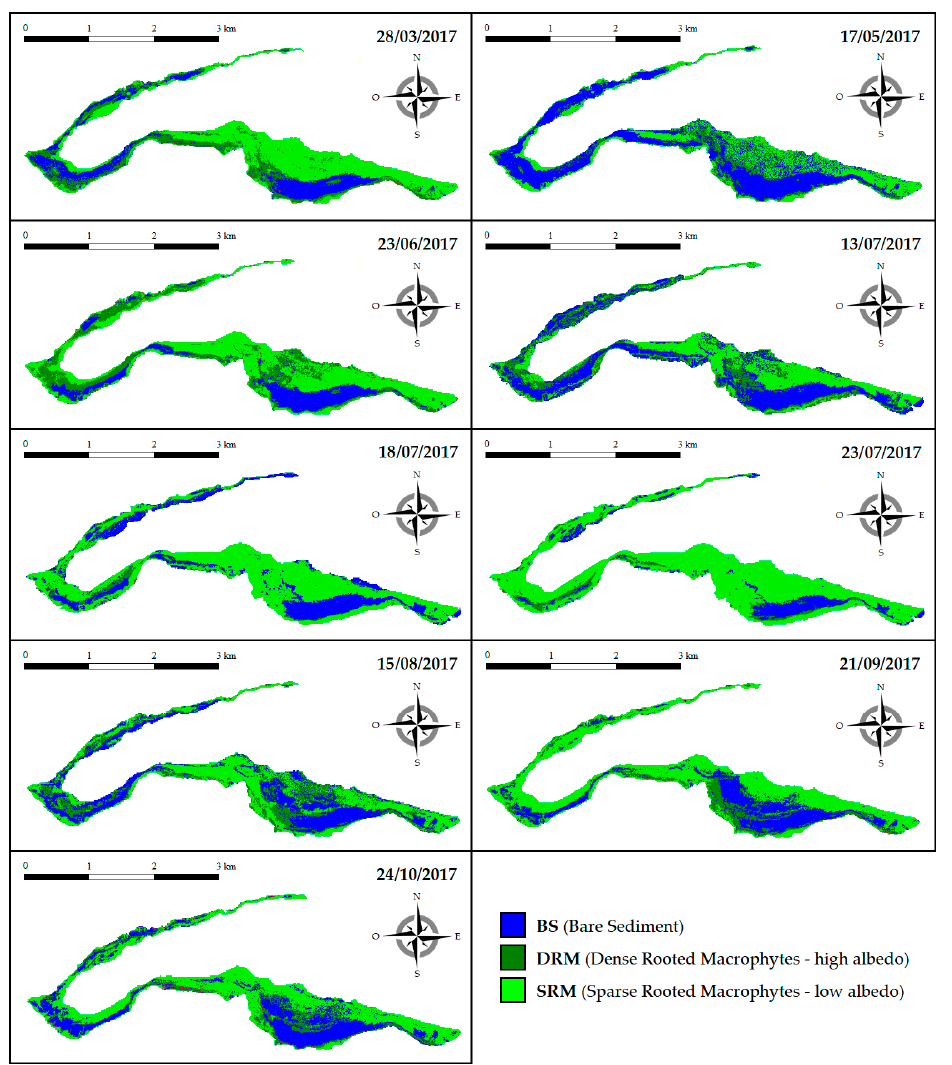
Figure 3. Spatial distribution of the three bottom cover classes [(BS, dense rooted macrophytes (DRM), and sparse rooted macrophytes (SRM)] during the 2017 growing season (from late March to late October).